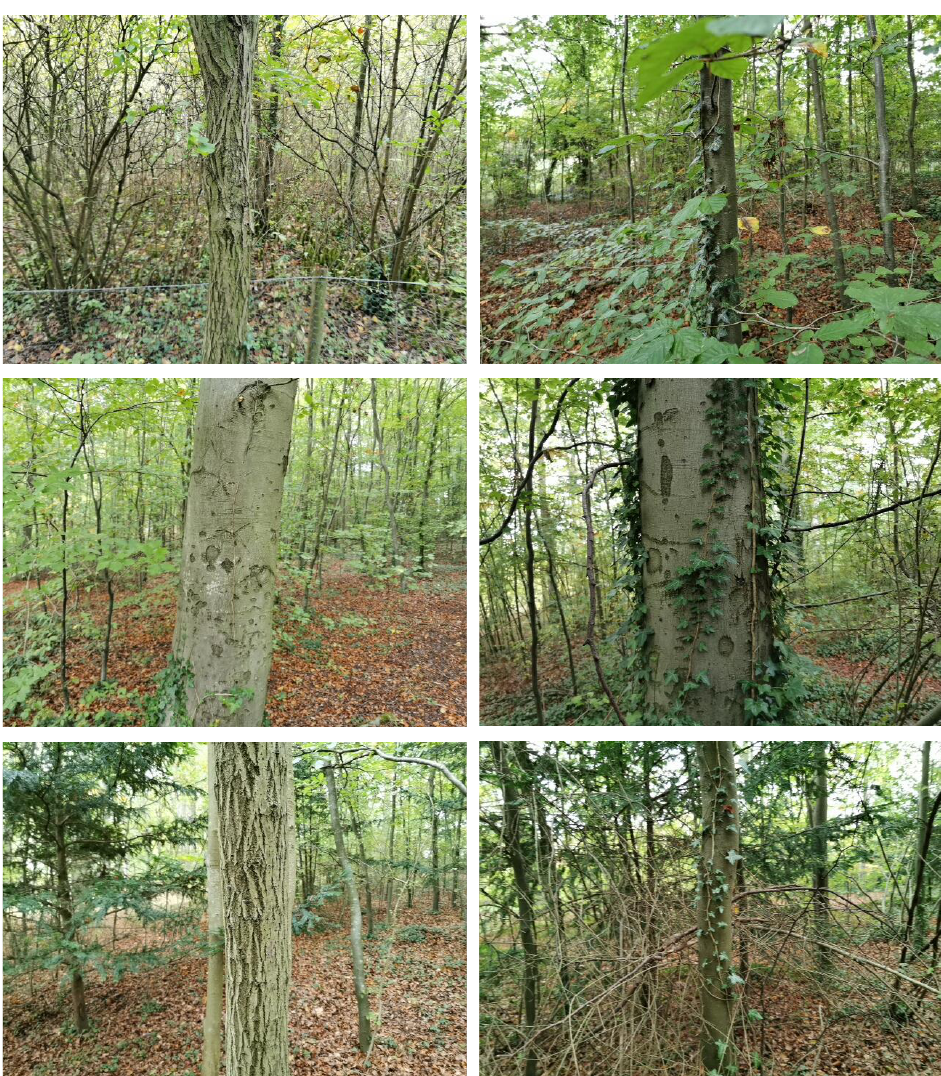
Figure A4. Sample RGB images from the Beechwoods data set, all of which correspond to the last (“best attempt“) image of a trunk based on user interaction. The images in the left column are categorized as “low” occlusion because they have few to no leaves or branches in front of the target trunk. The images in the right column were categorized as “medium“ or “high”